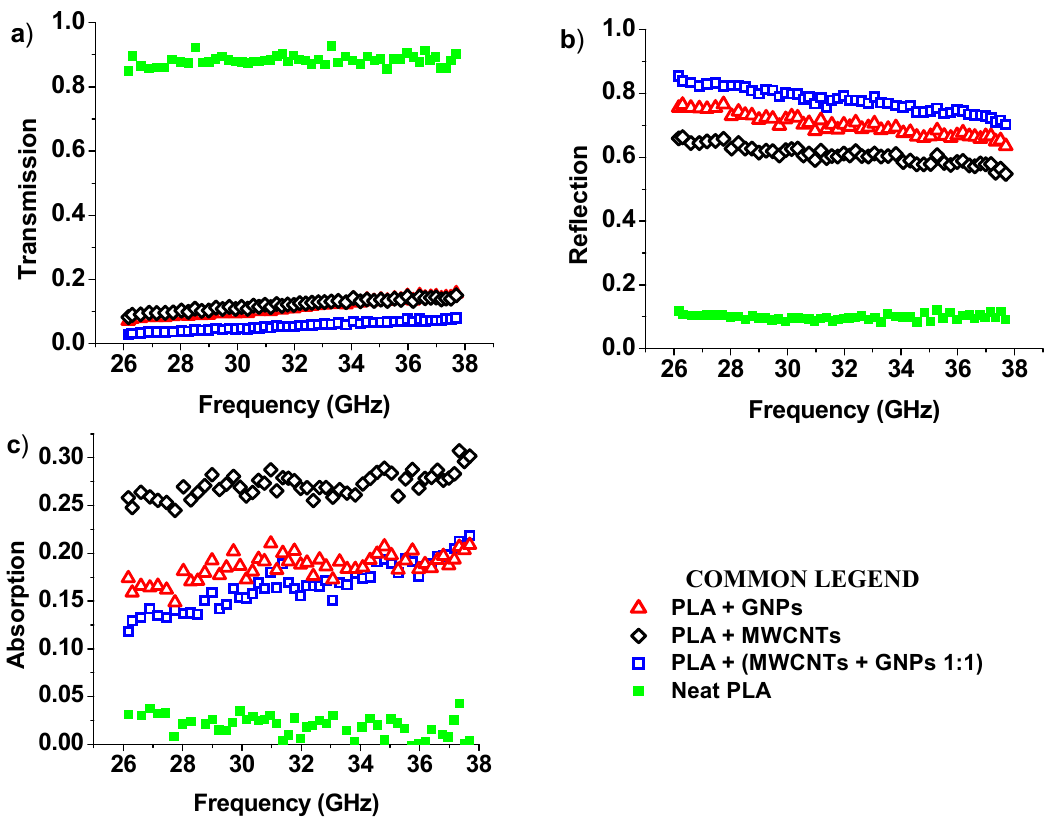
Figure 11. Transmission ( a ), reflection ( b ), and absorption ( c ) spectra in Ka-band for neat PLA and samples at the 12 wt % of total charge. Table 4. Electromagnetic properties at 30 GHz. Table 2. Thermal conductivity (W/mK). Figure 8. Thermal conductivity of carbon nanotubes (CNT)/PLA, GNP/PLA and (CNT + GNP 1:1)/PLA composites, as varying the filler contents. Markers represent experimental data, whereas lines are the interpolation curves.